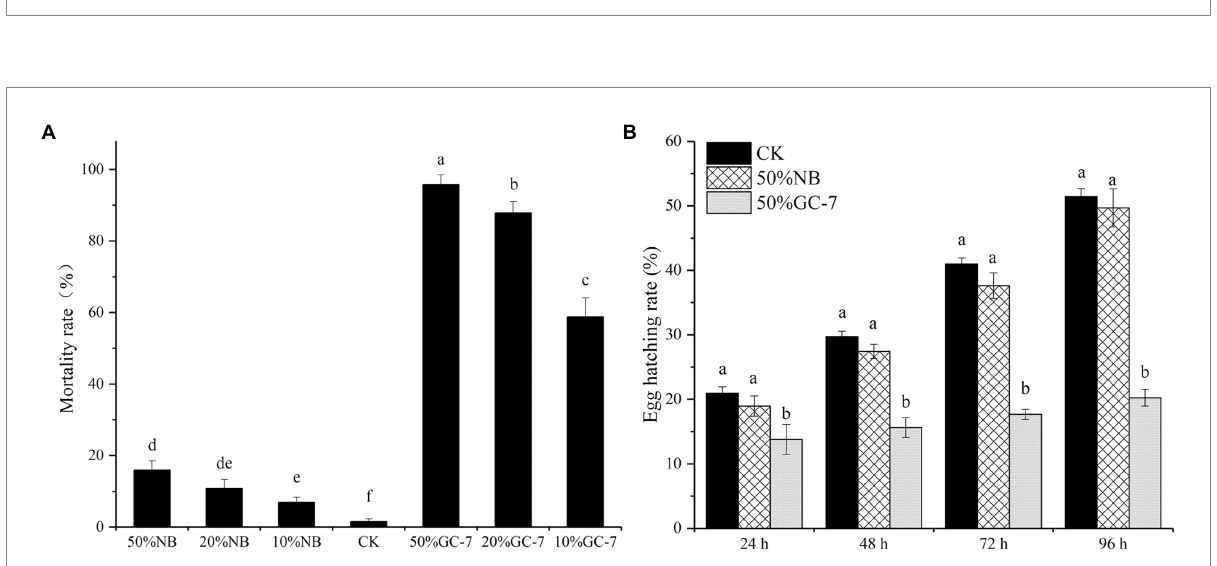
FIGURE 2 Evaluation of the nematicidal activity of Pseudomonas rhodesiae GC-7 in vitro . (A) Effects of isolate GC-7 on second stage juveniles (J2s) mortality of M. graminicola in vitro . Mortality rates were assessed by M. graminicola J2 incubated in fermentation cell-free supernatant of GC-7 at different concentrations in 24-well plates at 28 ° C for 24 h. J2 suspension mixed with different concentrations of NB medium, and sterilized water was used as control (CK). (B) The egg hatching rate of M. graminicola exposed to Pseudomonas sp. GC-7 cell-free supernatant in vitro . The egg hatching rate was evaluated by treating approximately 100 eggs with 50% GC-7 supernatant for 24 h, 48 h, 72 h, and 96 h at 28 ° C. The negative control was sterilized water. The results are from three independent experiments, each containing four replicates. The data were analyzed by Tukey’s multiple range test ( p < 0.05) using SPSS software. Error bars represent standard deviation, different letters represent a significant difference at p <